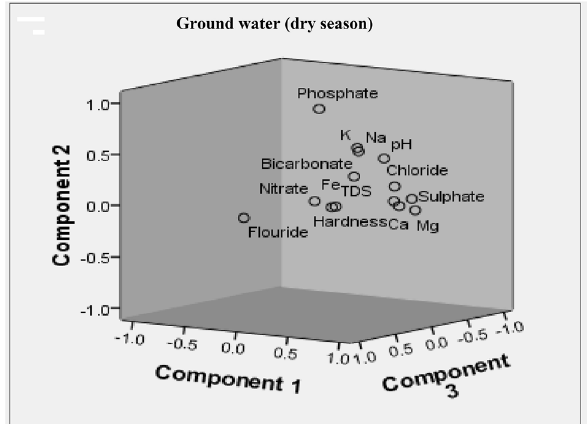
Fig. 4 Principal component analysis (PCA) for the selected aquifers in the dry season